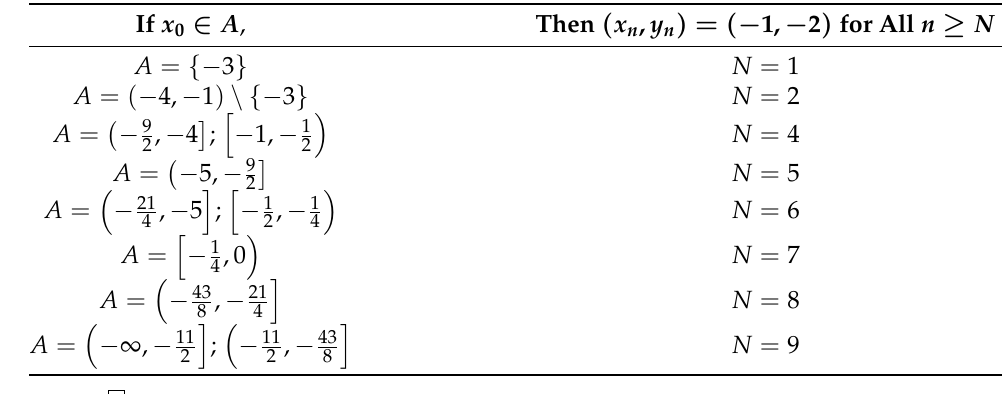
Table 3. Cases for x 0 < 0 and y 0 =